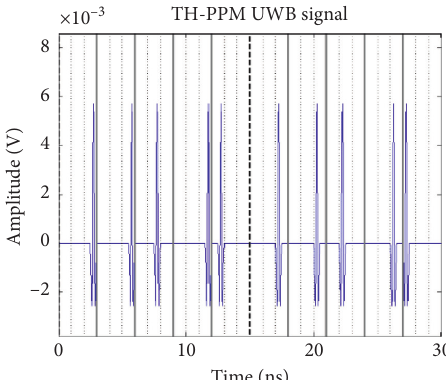
Figure 1: Time-domain waveform of UWB pulse